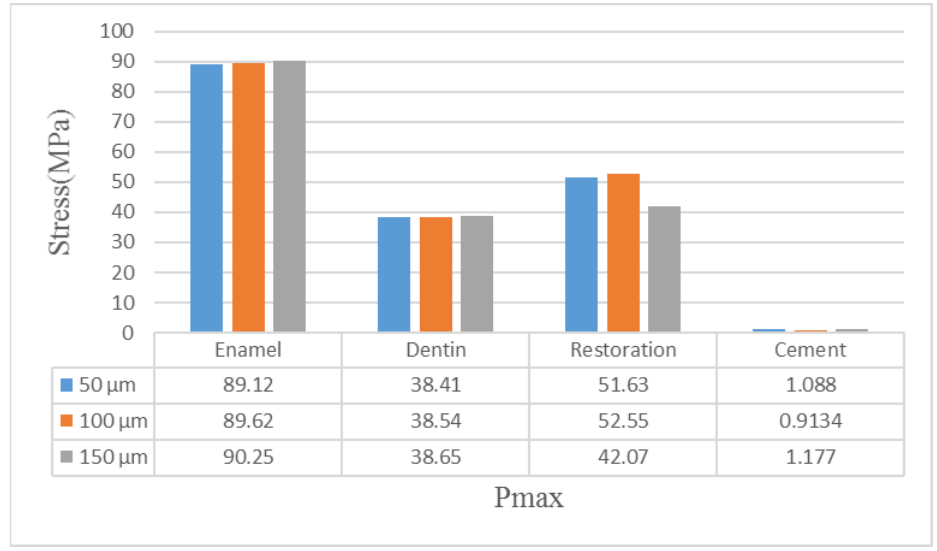
Figure 4. Maximum principal stress distribution in restorations with RC in different thicknesses (35 GPa Young’s modulus of amalgam).